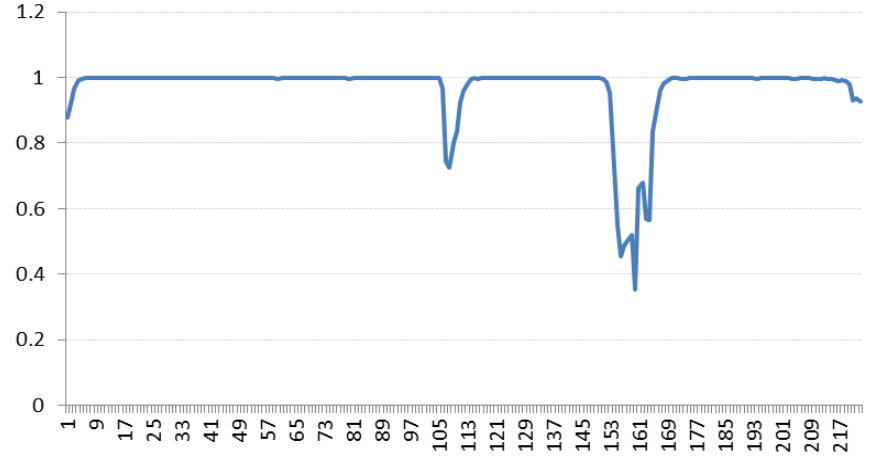
Figure 13. Average scene correlation for continuous band for Lunar Lake.